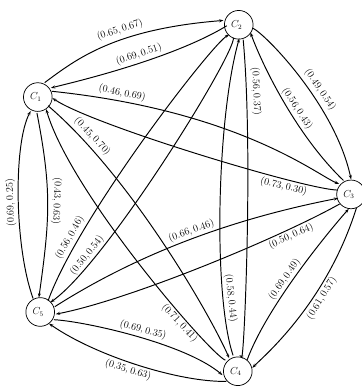
Figure 16. Directed network of the fused PFPR.